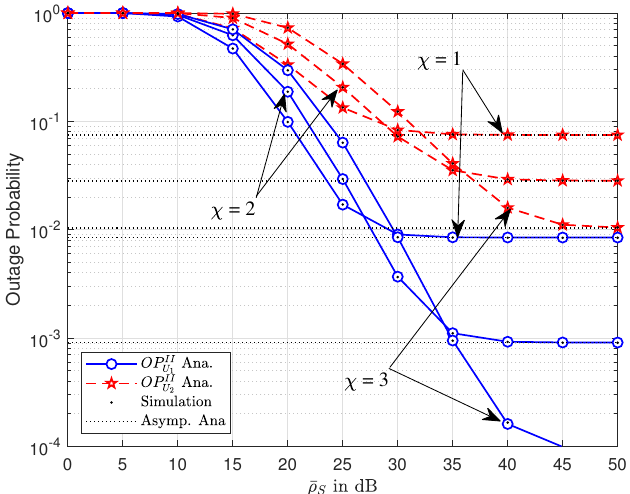
Figure 4. Outage performance of U 1 and U 2 versus ¯ ρ S with varying χ .